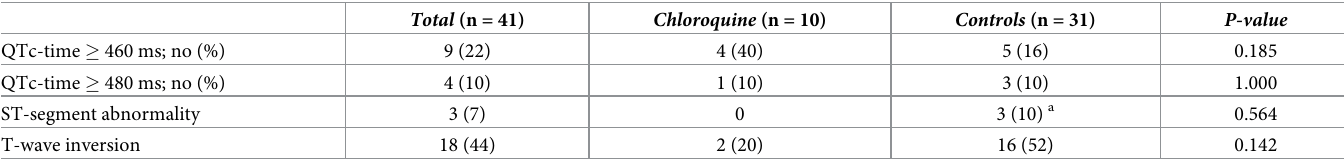
Table 3. ECG analyses of 41 participants.